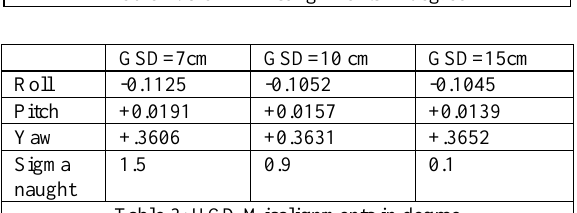
Table 3: UCD Misalignments in degree